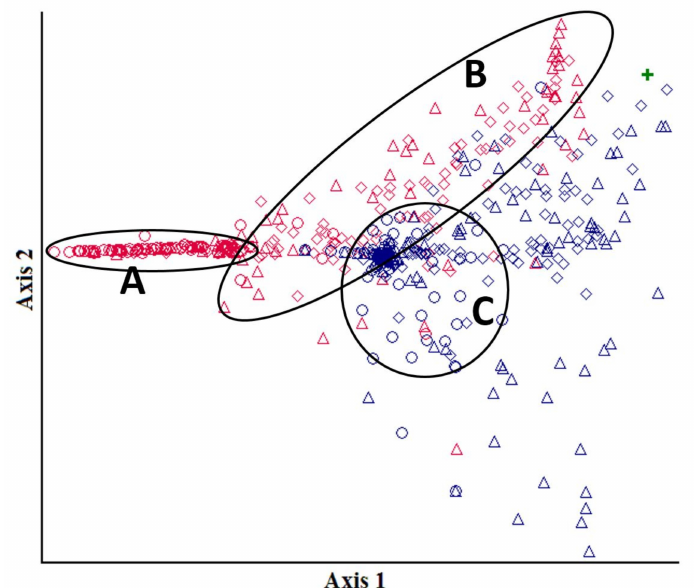
Figure 9. Ordination plot for geobotanic relev é s of ground vegetation (similarity in the space formed by the first two DCA axes) in a bilberry-type spruce stand site 3 and 10 years after surface fire. Legend: —SP 6 in 2014, —SP 6 in 2020, —SP 8 in 2014, —SP 8 in 2020, —SP 9 in 2014, —SP 9 in 2020. A–C—see text for explanations. Axis loadings: axis 1—0.33, axis